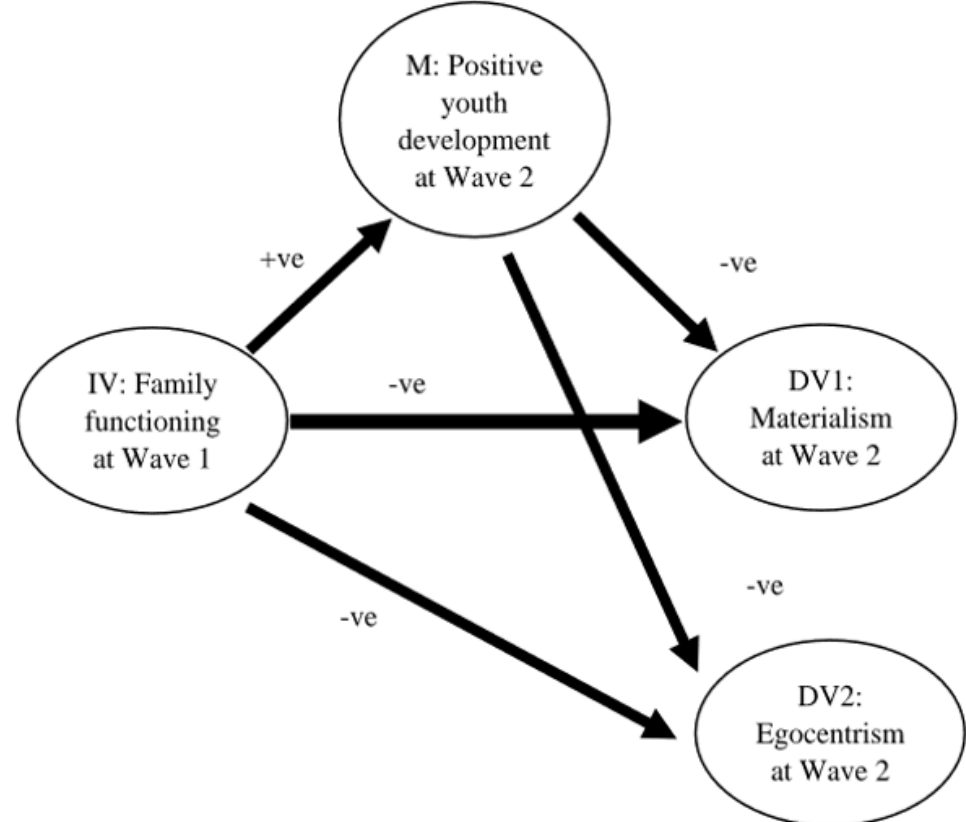
Figure 1. Conceptual model for the mediating effect of positive youth development at Wave 2 on the paths from family functioning at Wave 1 to materialism and egocentrism at Wave 2. Note. IV = independent variable, M = mediator, DV = dependent variable, +ve = hypothesized positive rela- tionship, − ve = hypothesized negative relationship.